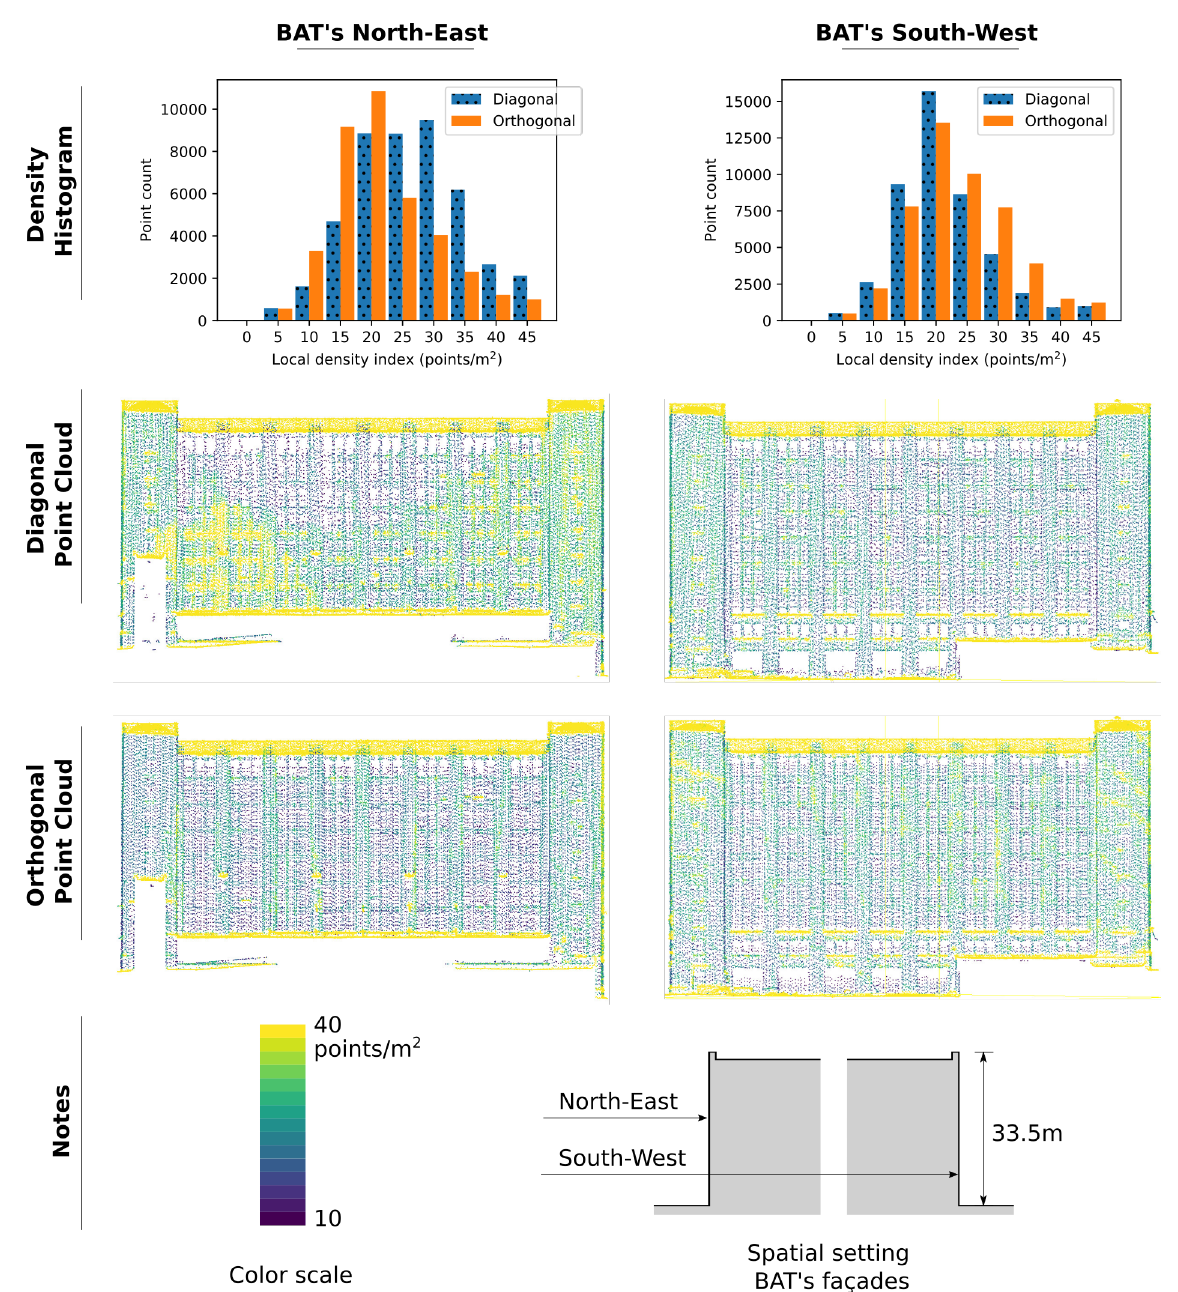
Figure 12. Façades not susceptible to street occlusion—the Diagonal flight grids captured more vertical points on the North East façade but less vertical points on the South East